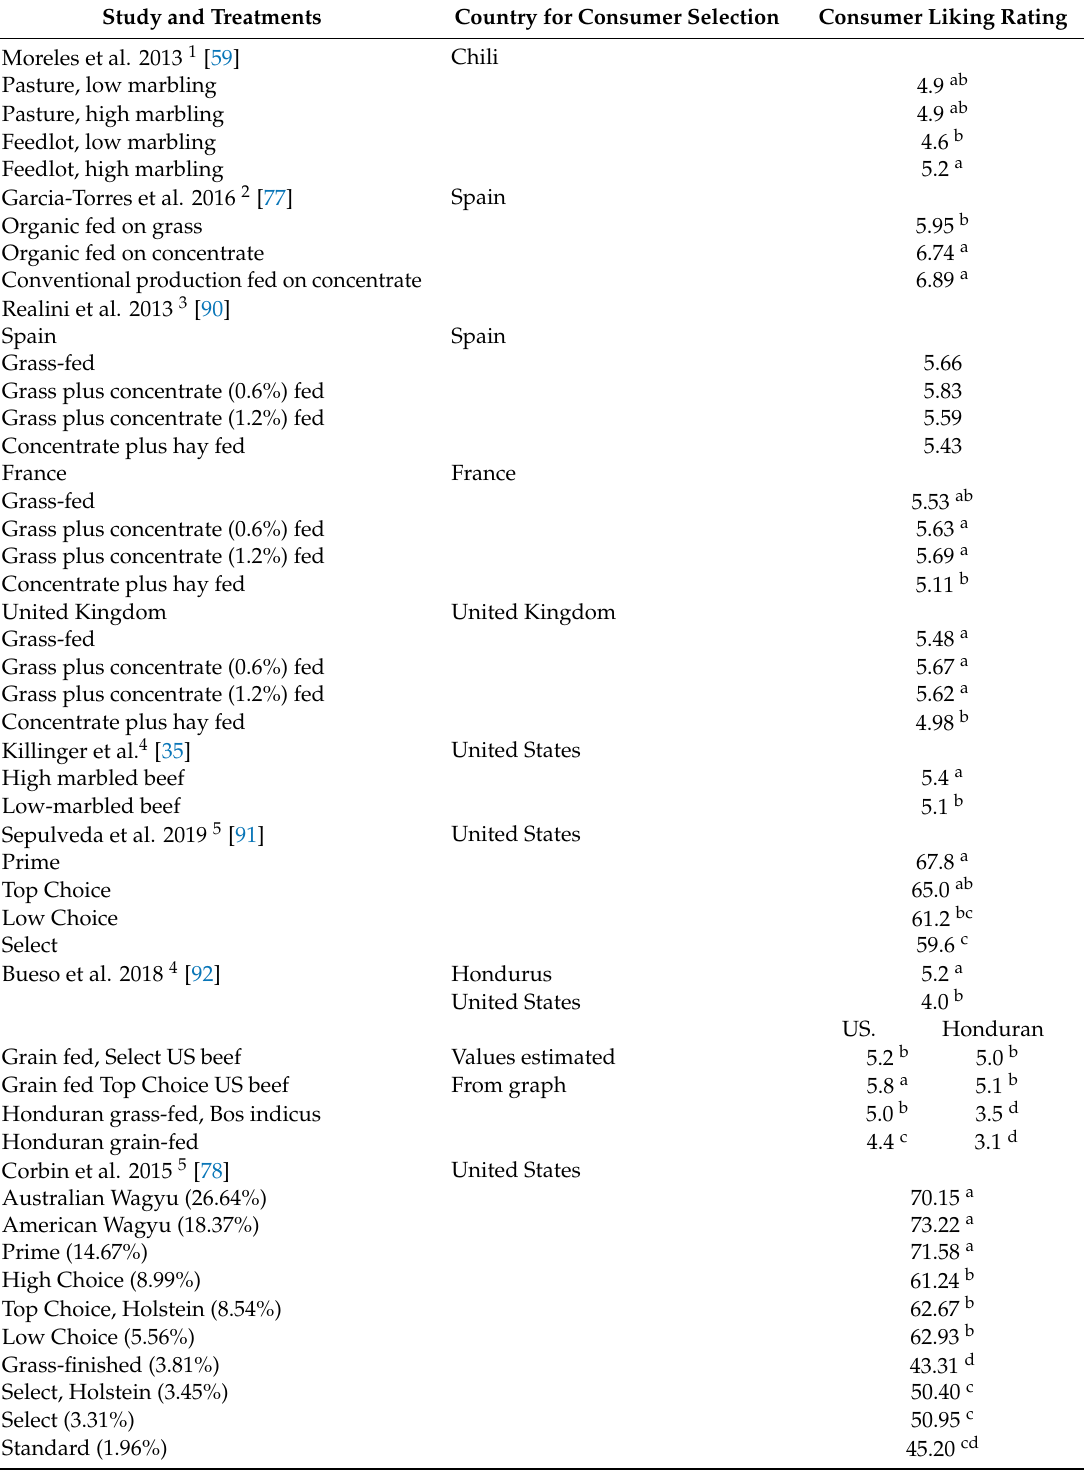
Table 1. Selected studies examining consumer overall liking of